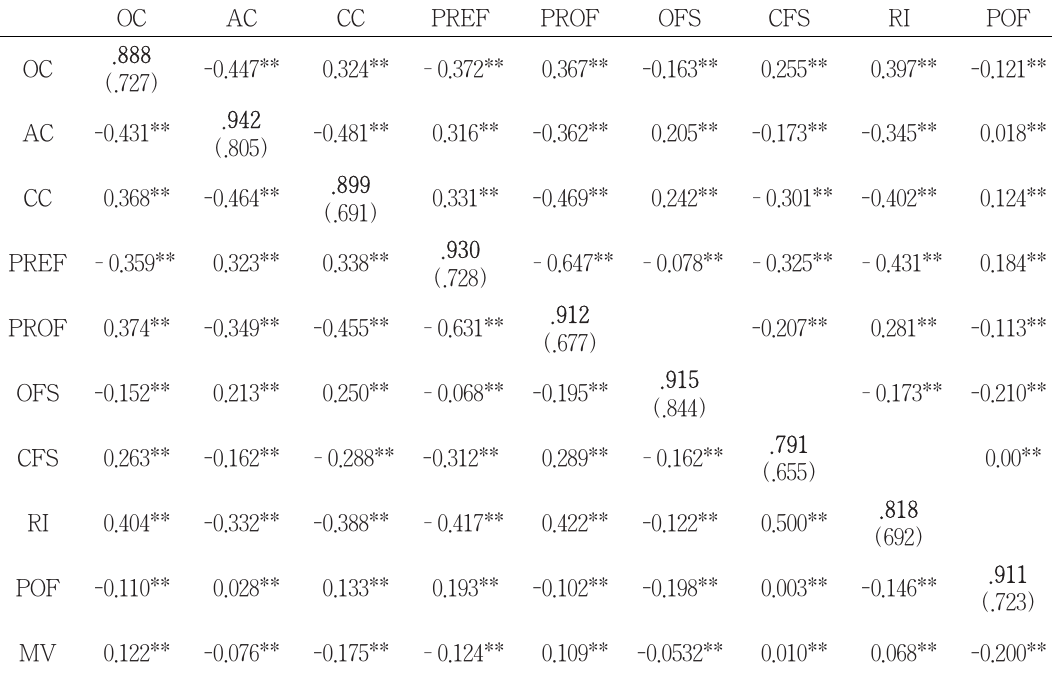
<Table 1> Measure Correlations, Average Variance Extracted and Composite